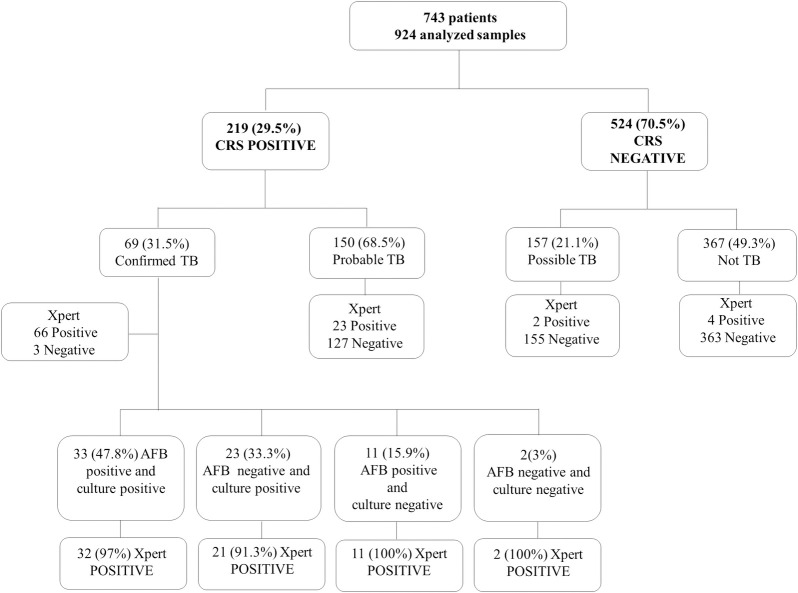
Flowchart of the patients included and diagnostic classifications.Indeterminate cases were excluded from the CRS reference standard. All percentages report the proportions of the respective patients, relative to the 743 patients studied.